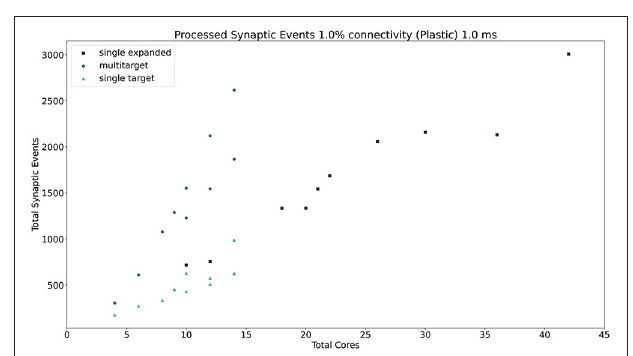
FIGURE 13 | Resource allocation vs. peak performance for the three different approaches ( single target expanded , multi-target , and single target ). The network is the same used for Figure 12 , with 1% connectivity and plastic connections. The color scheme matches that used in Figure 12 . For a case by case labeled version of this plot, please refer to the Supplementary Material